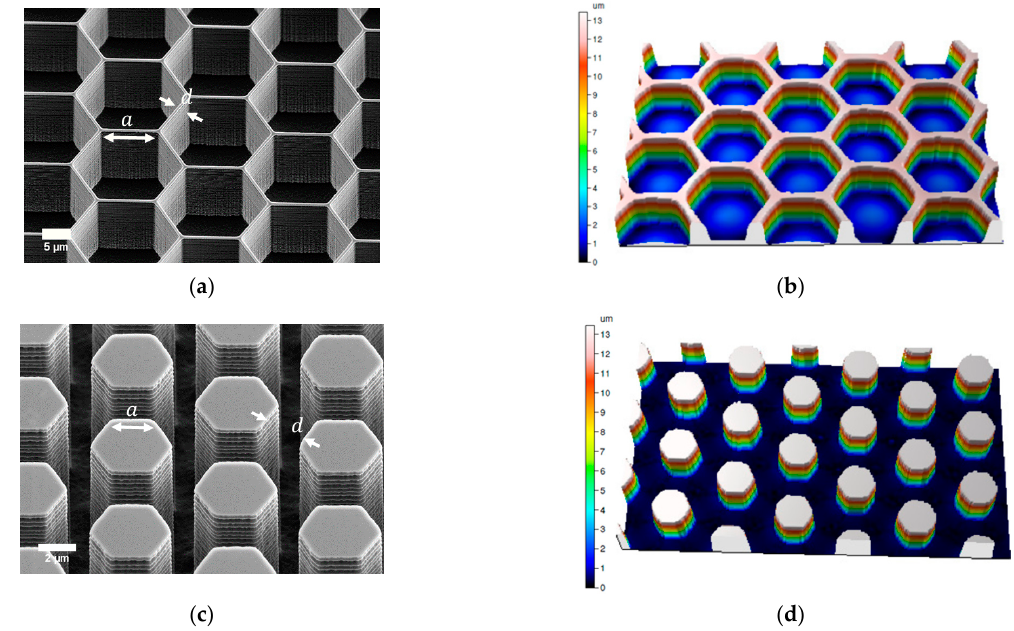
Figure 1. Scanning electron micrographs and matching 3D profiles, taken using an optical profiler (Sensofar PLu Neox 3D), of different microstructured honeycomb patterns after the silicon etch process. ( a ) SEM image of an array of honeycomb pits with side length 𝑎 and wall width 𝑑 ; ( b ) Corresponding 3D profile of the honeycomb pits; ( c ) SEM image of an array of honeycomb pillars; ( d ) Corresponding 3D profile of the honeycomb pillars.